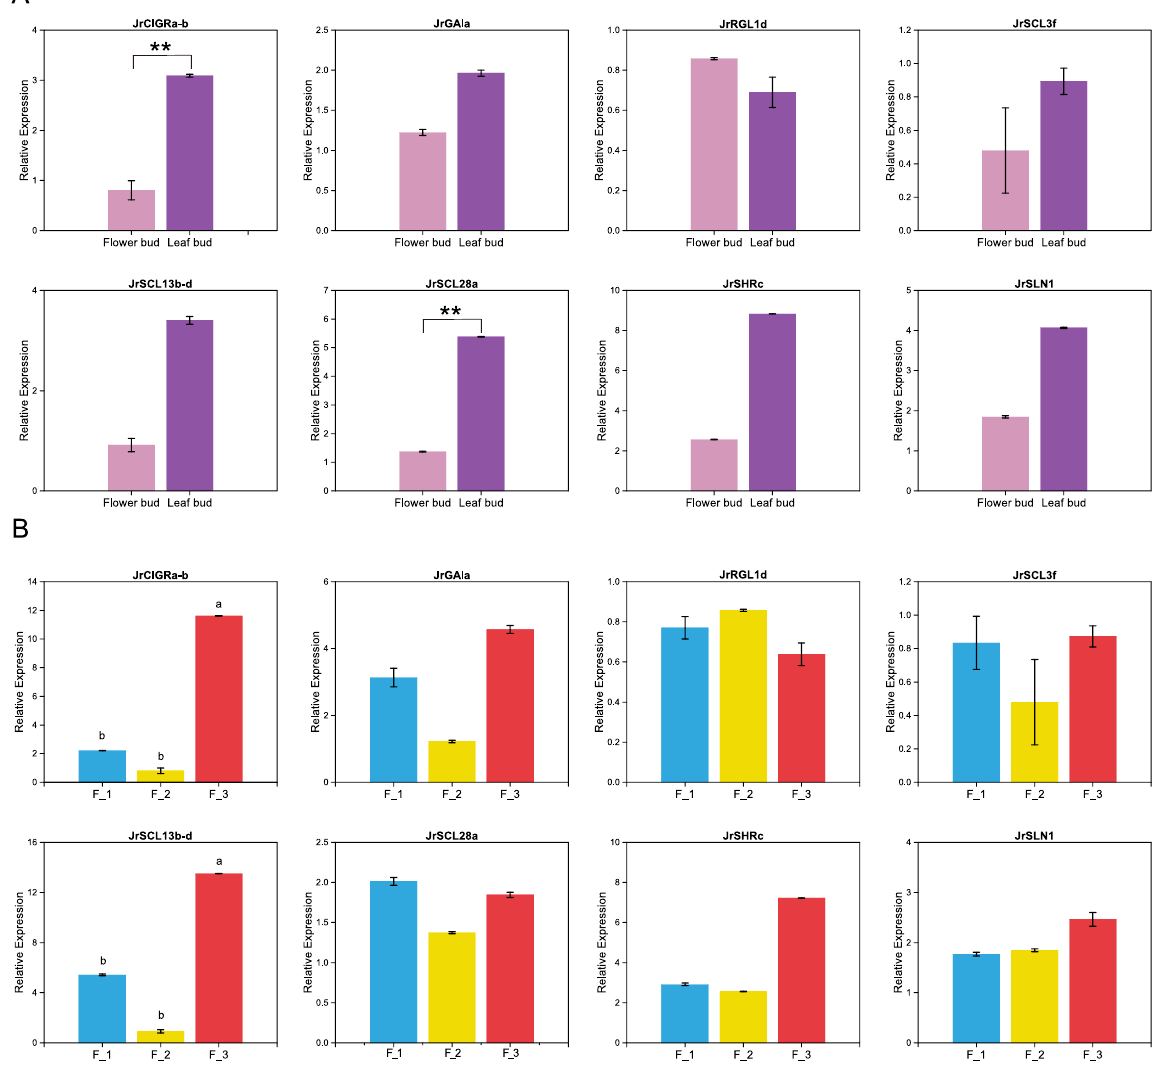
Figure 7. qRT-PCR analysis of JrGRAS genes in different tissues and different development period of flower